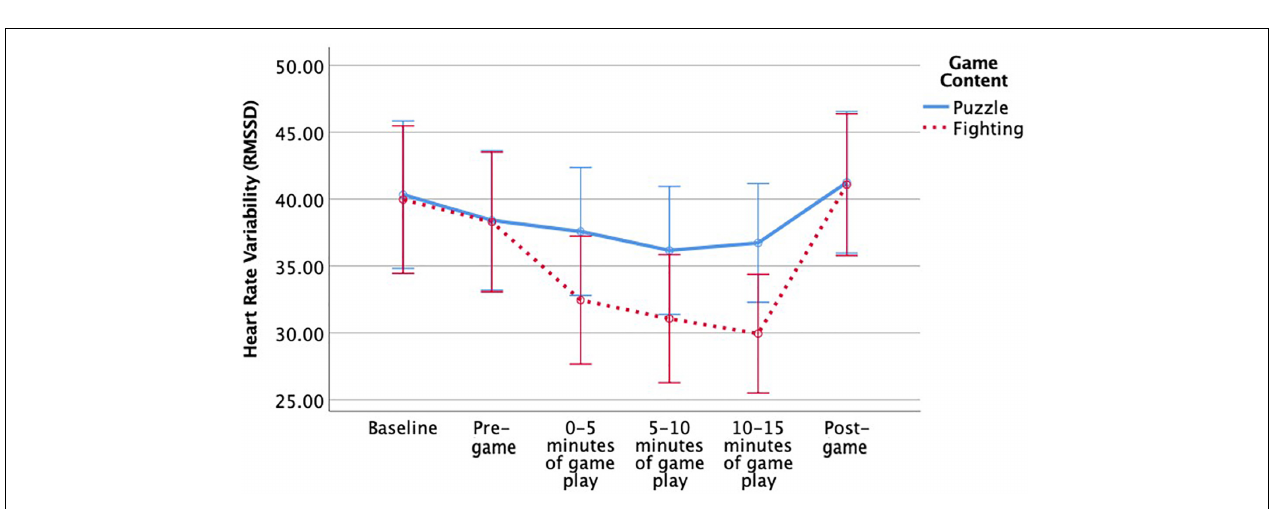
FIGURE 1 | Significant interaction effect of stress appraisal instructions on heart rate variability over time. Error bars are 95% confidence intervals.